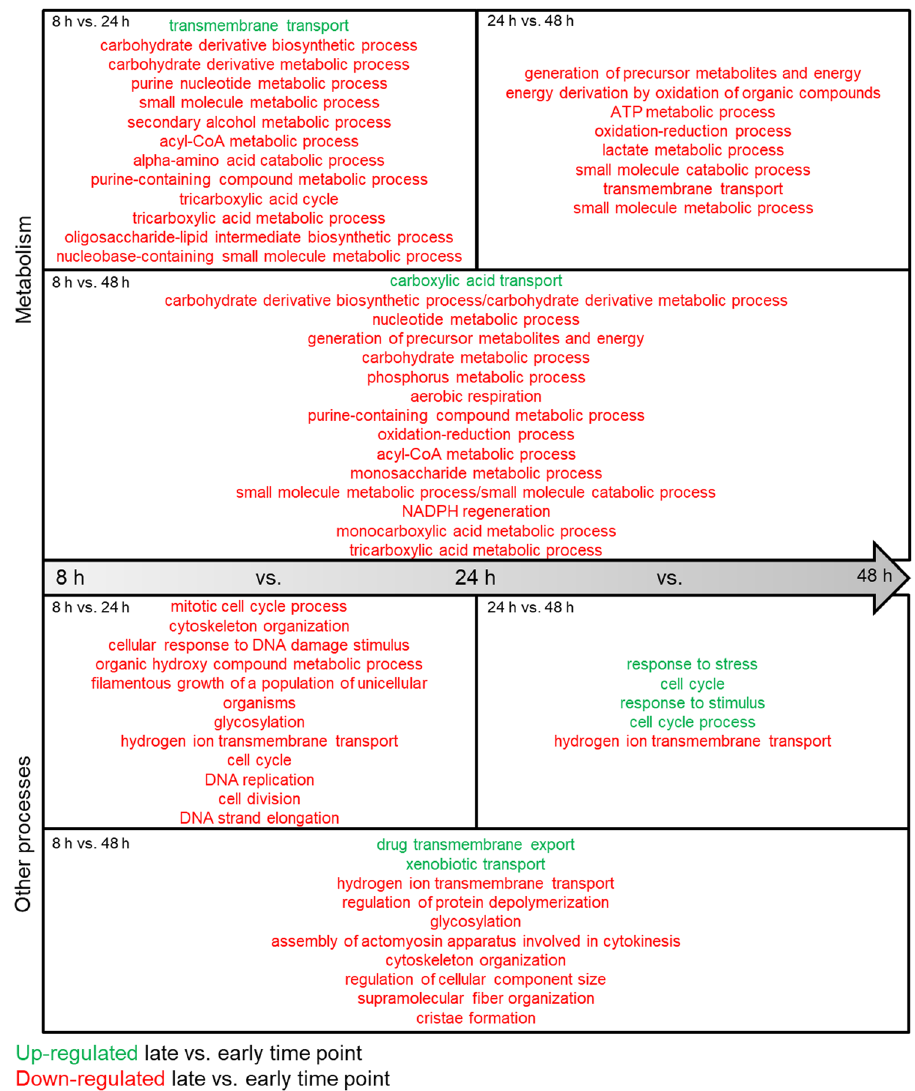
Fig. 1 Transcriptional responses in aging bio fi lms affect various metabolic processes. Differentially regulated genes (log 2 FC ± 1; p < 0.05) in late bio fi lms were compared to earlier time points (24 vs. 8 h; 48 vs. 8 h; 48 vs. 24 h) and GO terms for molecular processes were each summarized using REVIGO with a cutoff of 0.5 dispensability. Metabolism-related processes were separated from others. Up-regulated terms are shown in green, and down-regulated terms are in red. Source data are provided as a Source Data fi